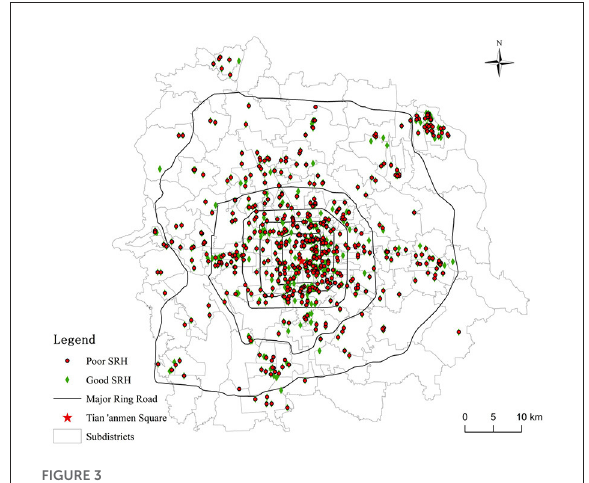
FIGURE3 Spatial distribution of SRH among respondents.